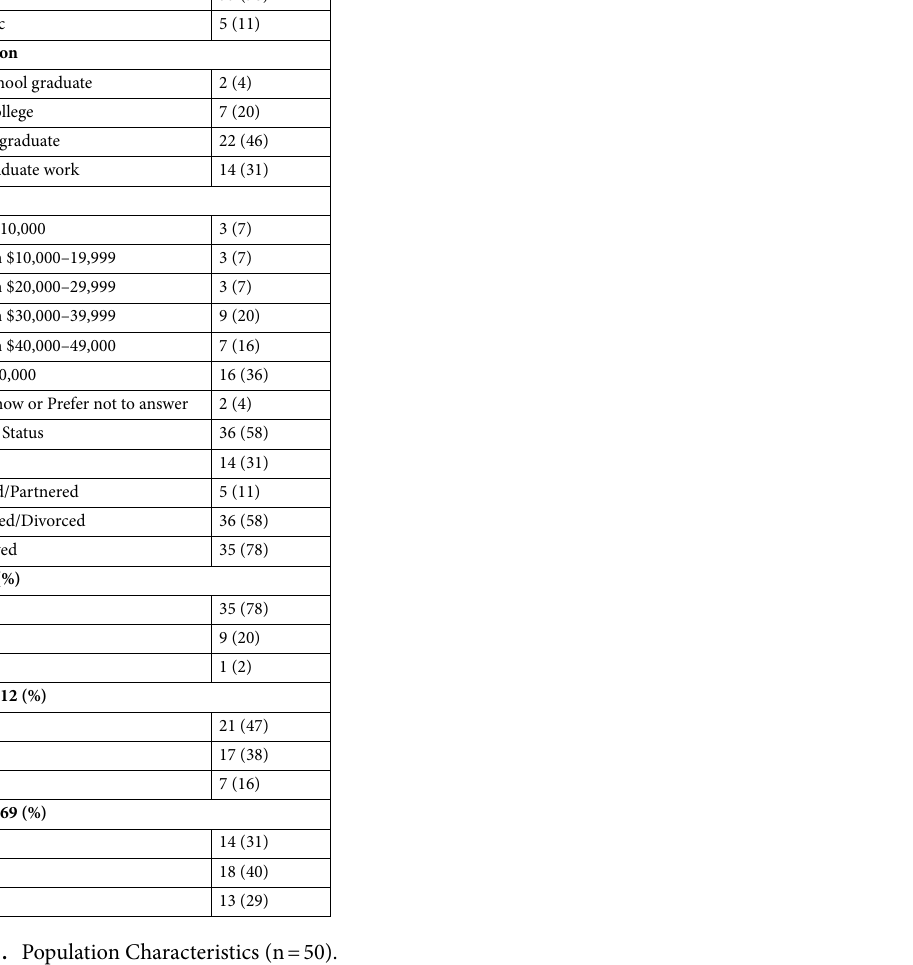
Table 1. Population Characteristics (n =